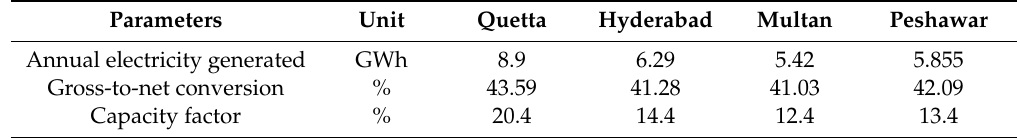
Figure 20. Electricity production by the 5 MWe PD system for different regions. Table 14. Performance parameters of the 5 MWe PD system.